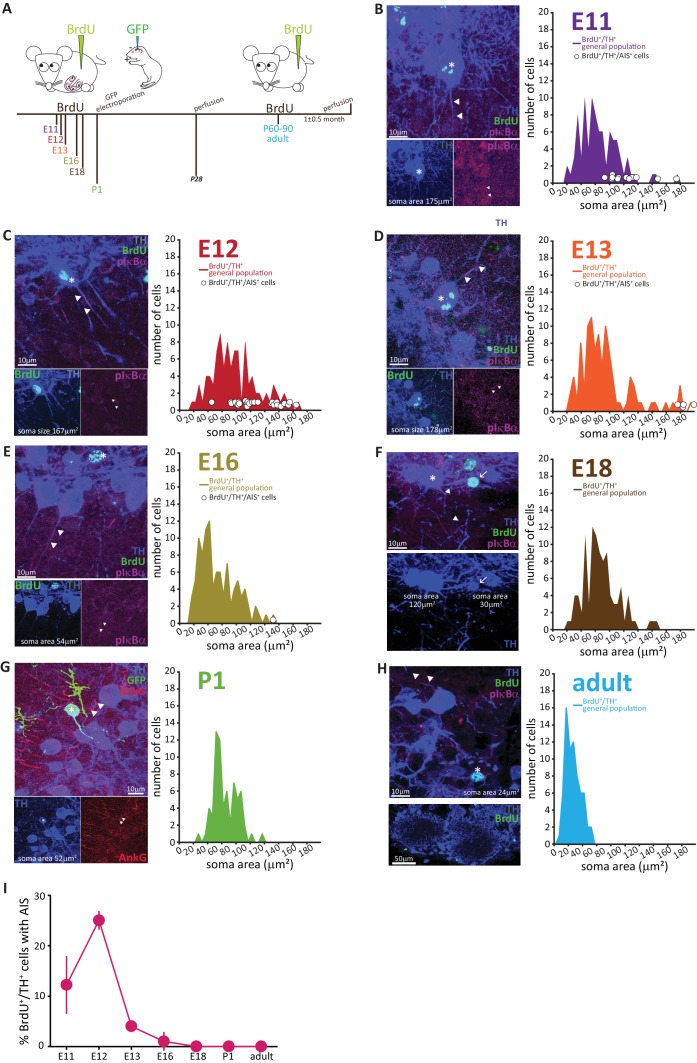
AIS-positive DA cells are generated exclusively in early embryonic development.(A) Schematic representation of the experimental strategy for birthdating experiments: pregnant wild-type mice were injected with a single dose of BrdU at different gestational days. Tissue was collected from their offspring at 1 month of age (P28), and also from the injected mothers which constitute the ‘adult’ group. We also labelled neonatally generated cells by electroporating GFP-encoding plasmid DNA injected into the lateral ventricles at P1. (B–H) Left: example images from OB slices stained with antibodies against BrdU (green), TH (blue) and the AIS markers pIκbα or AnkG (magenta). Asterisks indicate BrdU+/TH +cells; triangles indicate AIS start and end positions; in E-H AISes are indicated in BrDU- cells for comparison. Right: soma area distribution of BrdU+/TH+ DA cells (for each BrdU time point n = 100, N = 3; for P1 electroporation n = 68, N = 3; for adult mothers n = 70, N = 2). Circles indicate AIS-positive cells (BrdU+/TH+/pIκBα+) at their respective soma size value. (I) Summary graph indicating the percentage of AIS-positive cells (BrdU+/TH+/pIκBα+) generated at each developmental time point (mean ± SEM). No AIS-positive DA cells were born after E18.